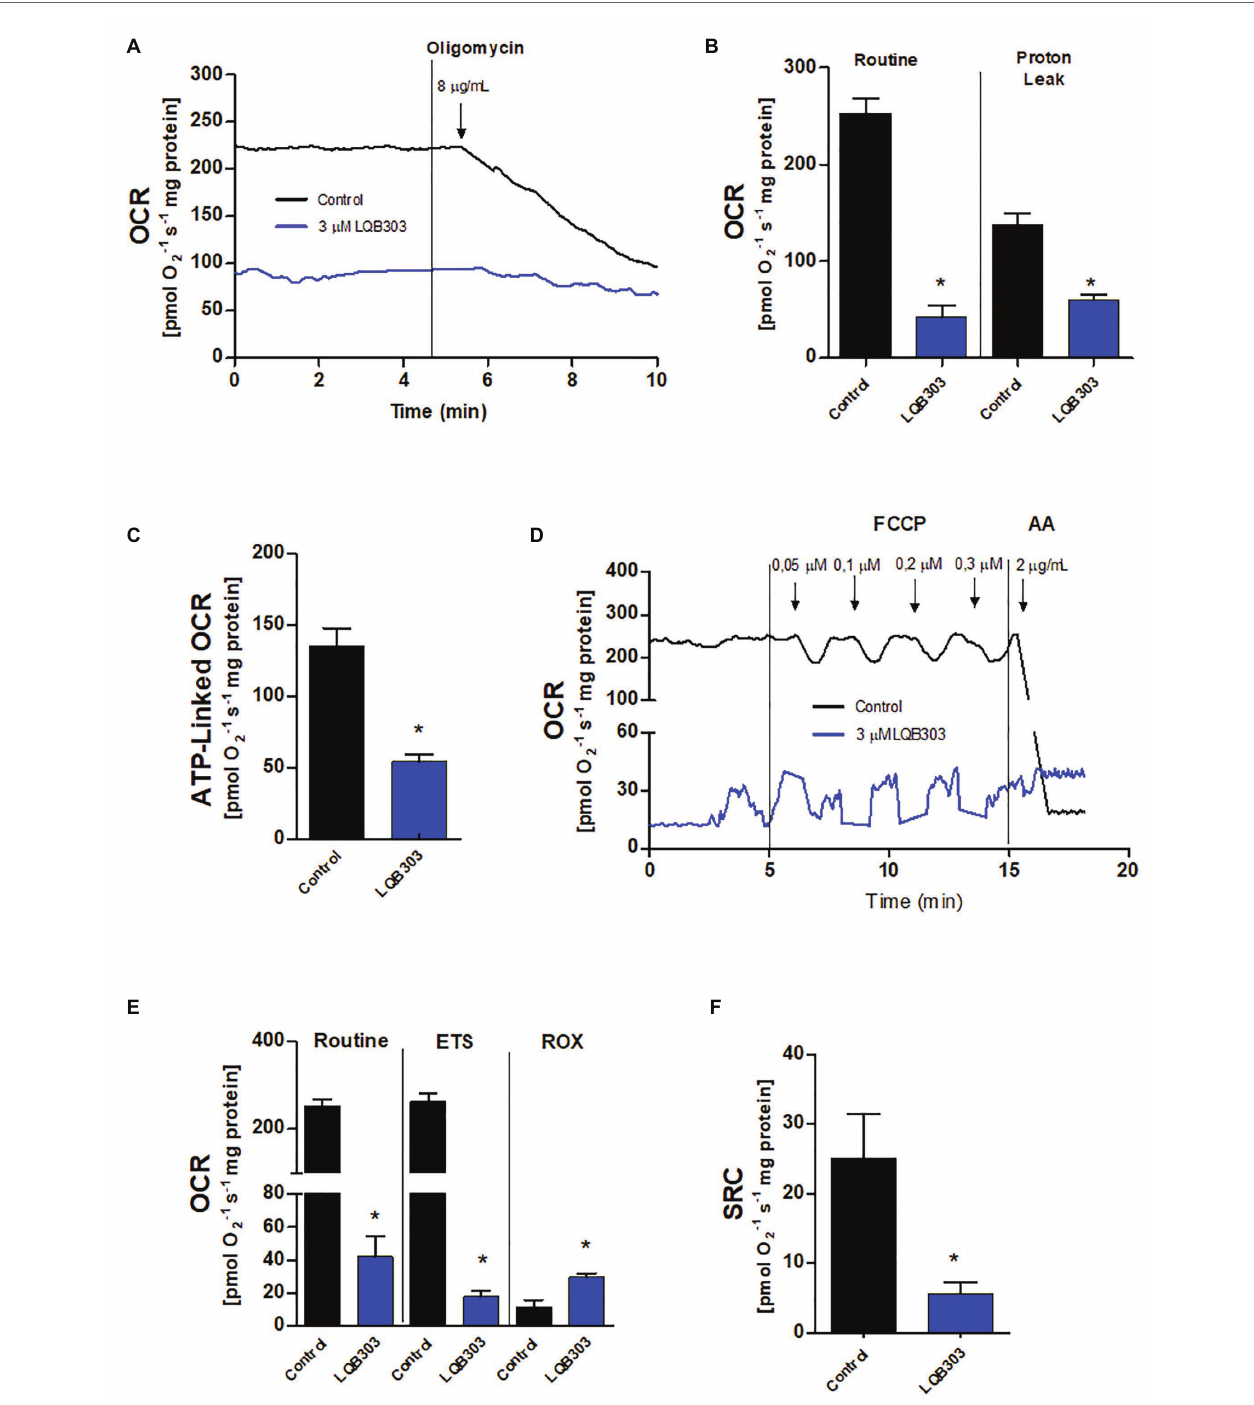
FIGURE 2 | Effect of LQB303 on the oxygen consumption rates of extracellular amastigotes. Extracellular amastigotes (5 × 10 7 cells/chamber) were incubated with LQB303 IC 50 /48 h at 37 ° C and then submitted to high-resolution respirometry. (A) Representative oxygen consumption rate (OCR) traces of extracellular amastigotes. Where indicated 8 μ g/ml oligomycin was added. (B) Routine OCR and Proton leak after the addition of 8 μ g/ml oligomycin. (C) ATP linked OCR was calculated by subtracting basal oxygen consumption rates after adding oligomycin. (D) Representative OCR traces of extracellular amastigotes. Where indicated increasing concentrations of up to 0.3 μ M FCCP were added. (E) Maximal oxygen consumption after ionophore FCCP titration. ROX = residual respiration after the addition of 2 μ g/ml AA. (F) Spare respiratory capacity (SRC) was estimated as the difference between maximal and routine OCR. All data are presented as average ± SE of at least three independent experiments, performed in duplicate, * p < 0.05 when compared to the control group by Student’s t